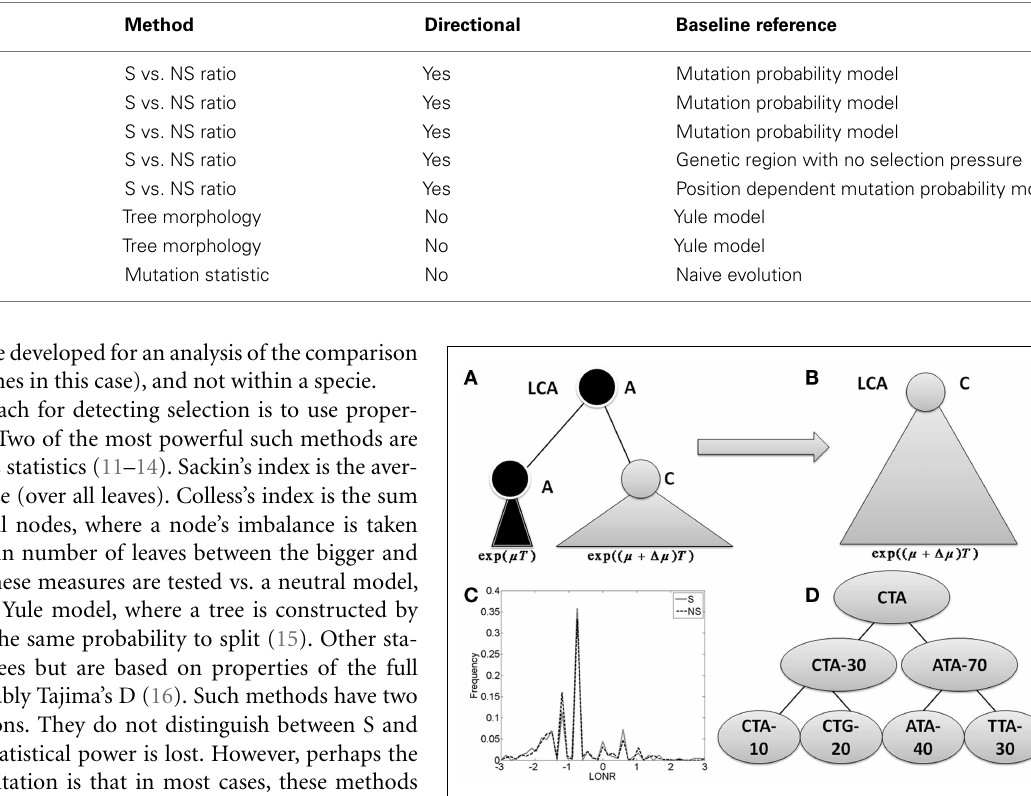
FIGURE 1 |The branch imbalance framework and examples . (A) Schematic view of a branch corresponding to a mutation event. Following a mutation, the population can be expanded (or reduced), the advantage will lead to an exponentially growing difference in the number of offspring in parallel branches descending from the same internal origin. T is the time from the mutation to the sampling time. (B) After some time, one branch will take over the entire sample, and the information carried in the ratio between the branches will be lost. (C) LONR values histogram for one simulated sequence pool, simulated under naive multiplication from unique ancestral sequence.While the average is not 0, there is no difference between branches following S and NS mutations. (D) Example of tree. In the left branch, a mutation occurred from CTA to CTG, and the ratio between the mutated and un-mutated branches number of offspring is 20/10. In the right branch, a mutation from ATA toTTA occurred, with a